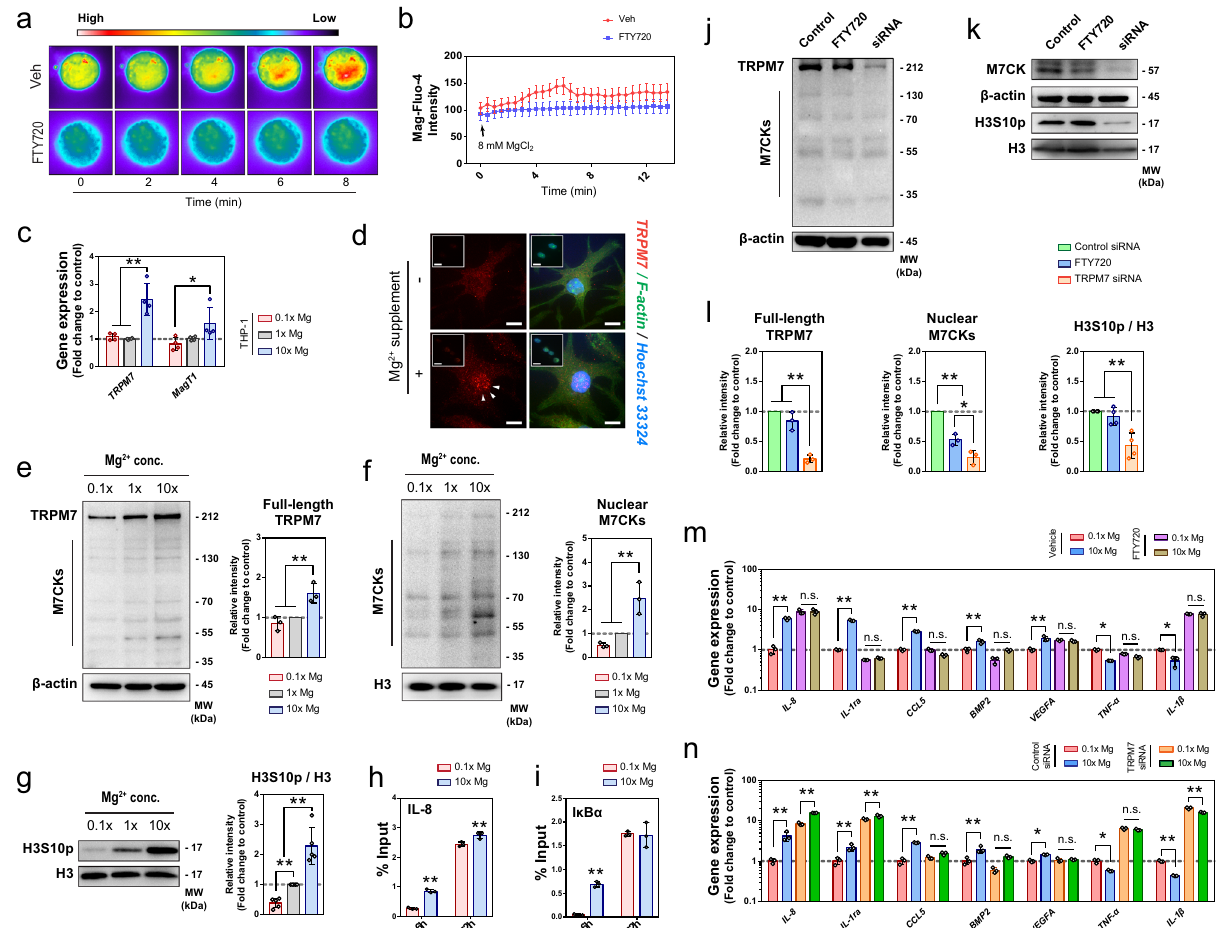
Fig. 5 The involvement of TRPM7 in Mg 2 + -induced immunomodulation in macrophages. a , b Representative fl uorescence images ( a ) showing the in fl ux of Mg 2 + into THP1-derived macrophages after the addition of 8 mM MgCl 2 . Color scale bar from low (black to blue) to high (red to white) indicates the level of Mg 2 + . b Time-course changes in intracellular Mg 2 + quanti fi ed by measuring the intensity of fl uorescence ( n = 5). c The gene expression of TRPM7 and MagT1 in THP1-derived macrophages upon the stimulation of different concentrations of Mg 2 + determined by RT-qPCR ( n = 4). d Representative fl uorescence images showing the nuclear accumulation of TRPM7 in THP1-derived macrophages after the stimulation of Mg 2 + . Inserts showed the staining with the cell permeabilization before the fi xation to better demonstrate the nucleus bound TRPM7. Scale bars = 5 µ m. e Representative western blots and the corresponding quanti fi cation showing the effects of Mg 2 + on the expression of TRPM7 and its cleaved kinase fragments (M7CKs) in THP-1 derived macrophages ( n = 3). f , g Western blots of nuclear proteins probed with anti-TRPM7 and the corresponding quanti fi cation showing the stimulation of Mg 2 + contributed to an increased nuclear fraction of M7CK ( n = 3) ( f ) and upregulated phosphorylation of Histone H3S10 ( n = 5) ( g ). h , i CHIP assay showing the detection of promoters of I κ B α ( h ) and IL-8 ( i ) in the immunoprecipitates of H3S10p was upregulated by the stimulation of Mg 2 + . ( j – l ) Representative western blots showing the effects of FTY720 and TRPM7 siRNA on the expression of TRPM7 ( j , n = 3), its nuclear M7CKs ( k , n = 3), and the phosphorylation of Histone H3S10 ( k , n = 4) in THP1-derived macrophages, as well as corresponding quanti fi cations ( l ). m , n The effects of FTY720 ( m ) and TRPM7 siRNA ( n ) on the in fl ammatory gene expression in THP1-derived macrophages ( n = 3). Data are mean ± s.d. n.s. P > 0.05, * P < 0.05, ** P < 0.01 by two-way ANOVA with Tukey ’ s post hoc test. ( c , h , m , n ) or one-way ANOVA with Tukey ’ s post hoc test ( e – g , l